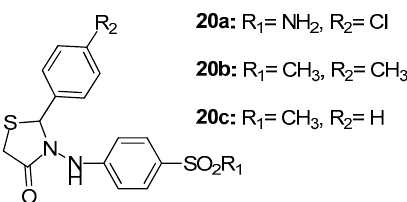
Figure 22. Chemical structures of 2-aryl-3-(4-sulfamoyl/methylsulfonylphenylamino)-4-thiazolidinones 20a – 20c .